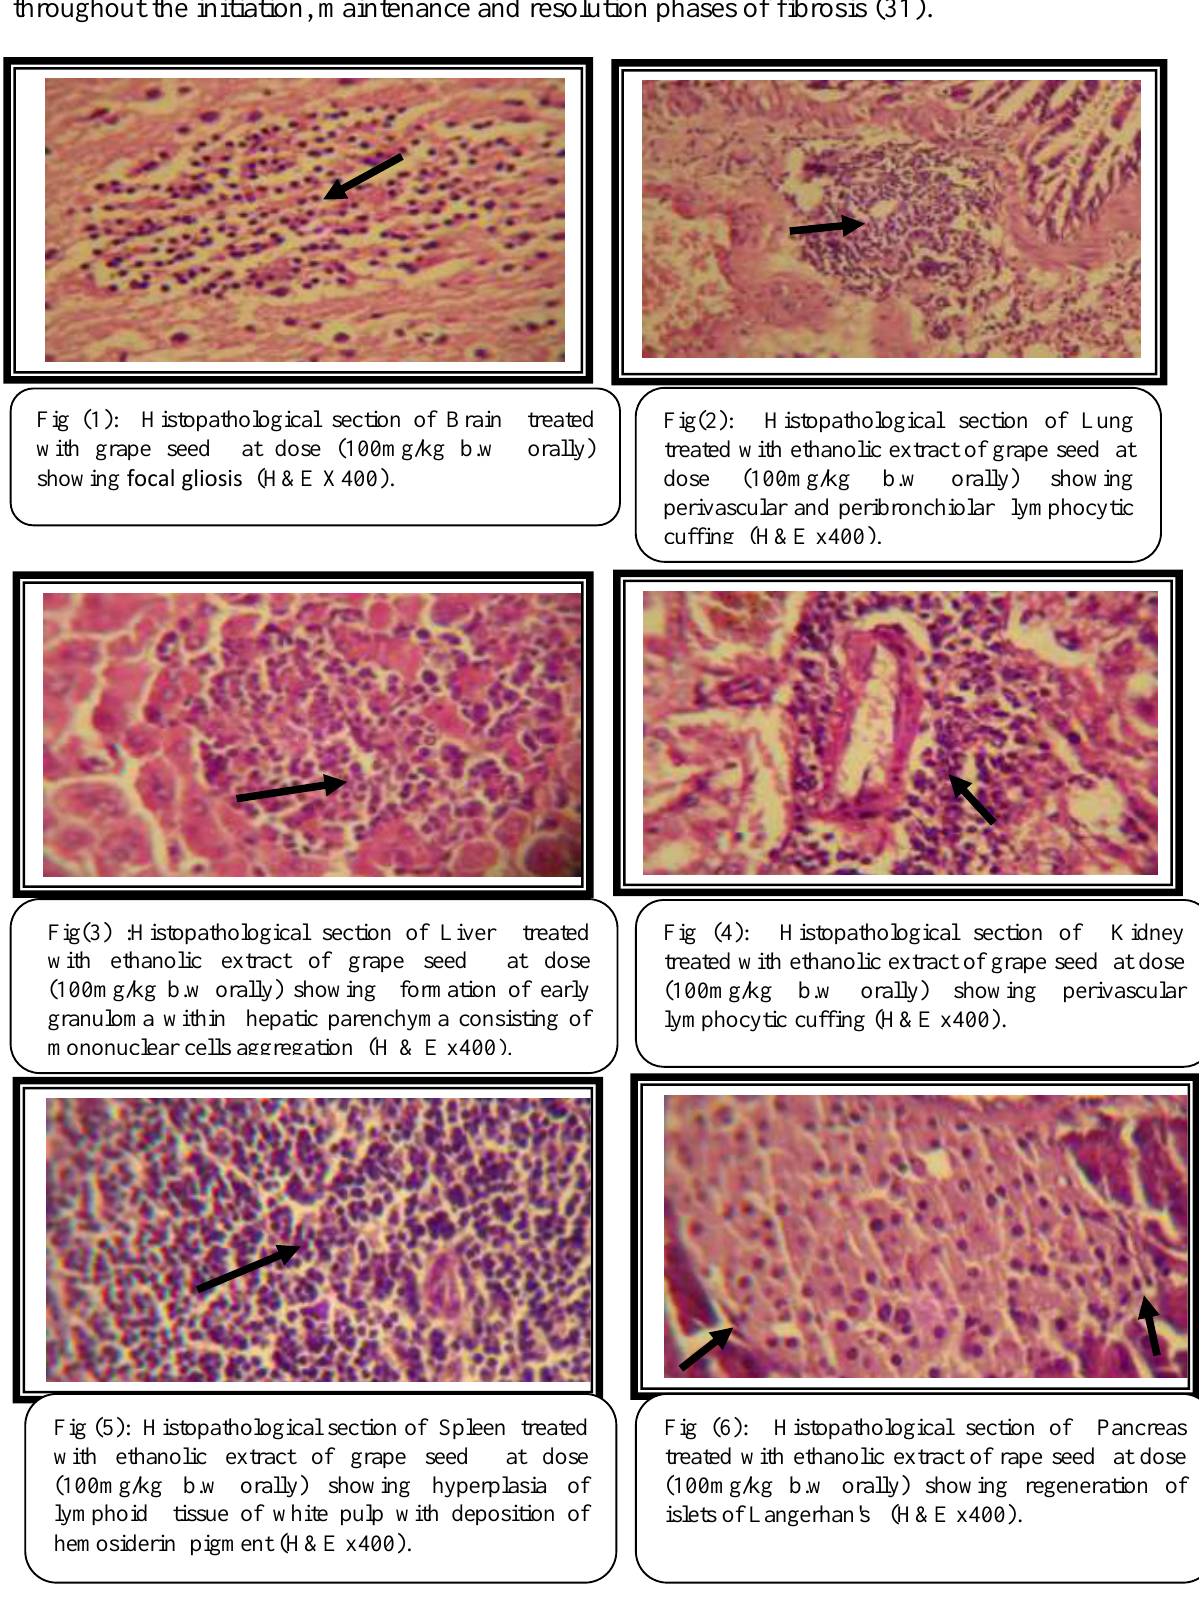
Fig (5): Histopathological section of Spleen treated with ethanolic extract of grape seed at dose (100mg/kg b.w orally) showing hyperplasia of lymphoid tissue of white pulp with deposition of hemosiderin pigment (H&E x400).